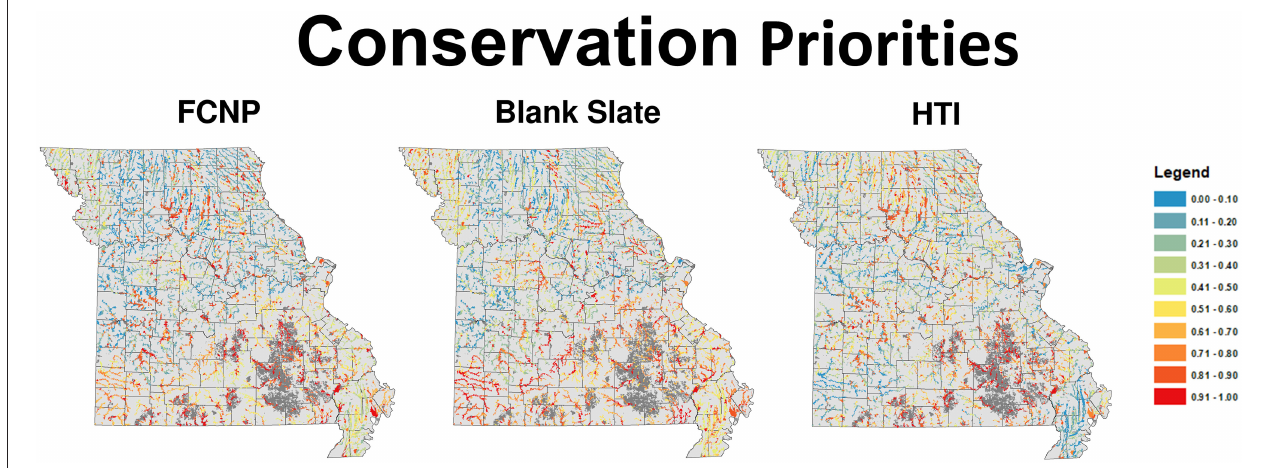
FIGURE 3 | Conservation priority scores for all wadeable streams in Missouri USA for each of the three approaches used in this research. Scores range from 0 (least valuable) to 1 (most valuable). FCNP, Freshwater Conservation Network Prioritization, HTI, Human Threat Index.